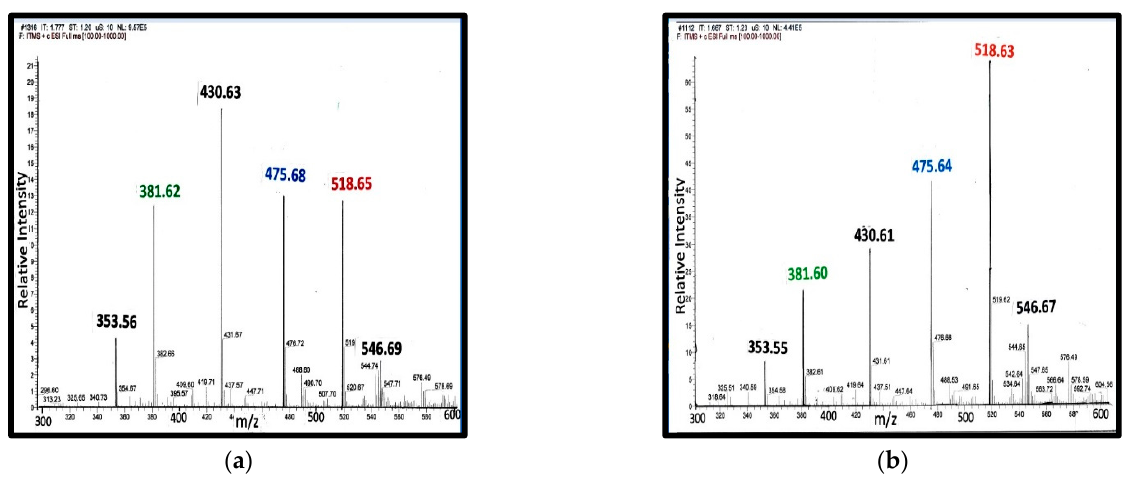
Figure 5. MS from serum steroid phosphodiesters during pregnancy: Panel ( a ) serum from a normotensive woman at 22 weeks of gestation; Panel ( b ) serum from a woman with pre-eclampsia at 22 weeks of gestation [28].